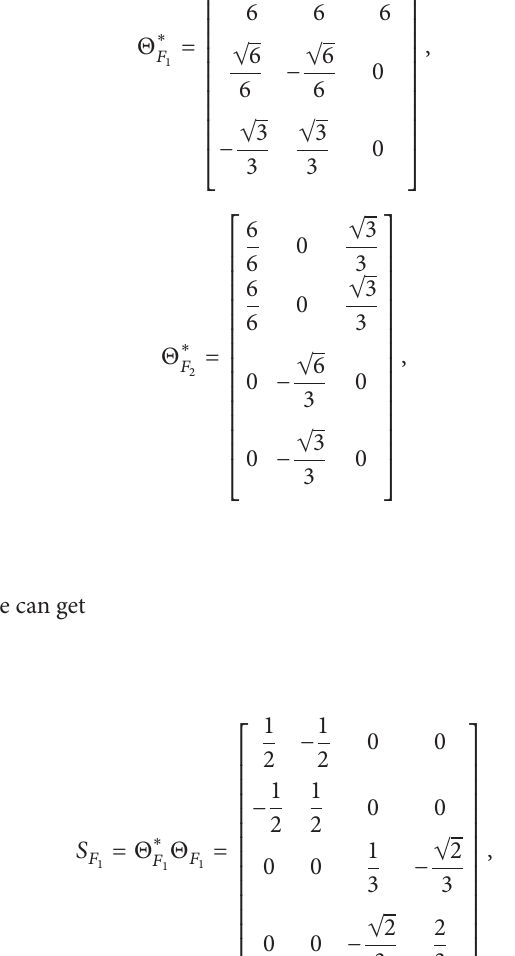
the reconstruction effect by comparing the two